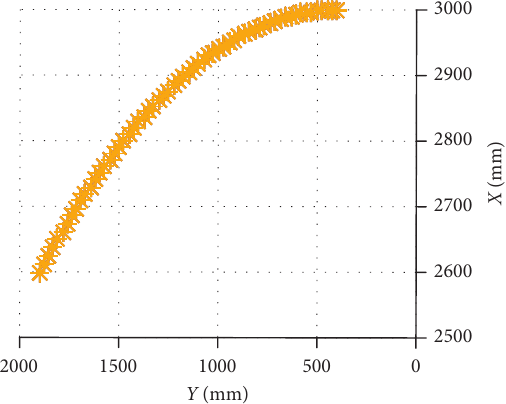
Figure 5: The points of the trajectory.